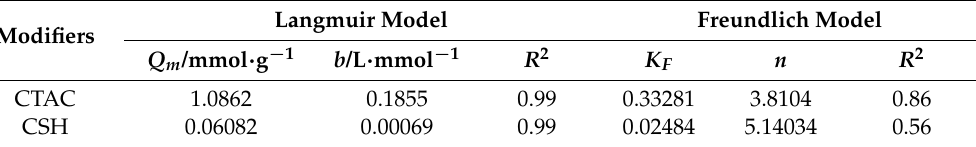
Table 3. The desorption results of organic modifiers from organomontmorillonite (OMt) under different initial pH